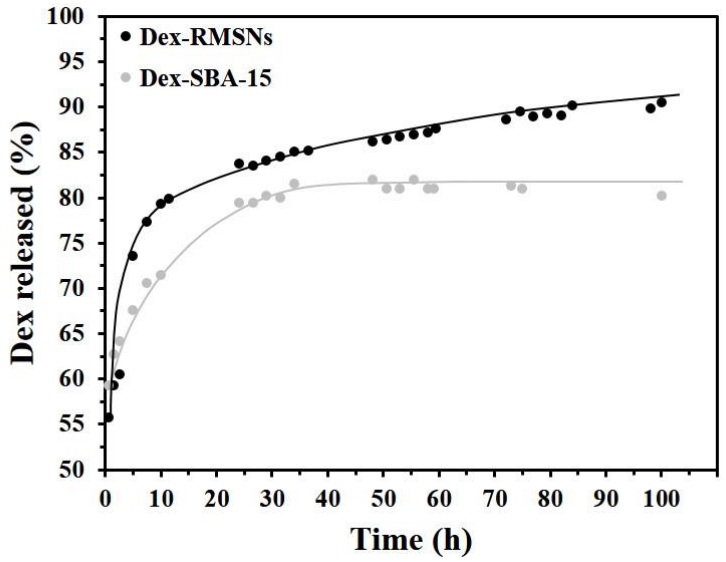
Figure 5. Time courses for release profiles of Dex from RMSNs and Figure 5 . Time courses for release profiles of Dex from RMSNs and SBA-15.